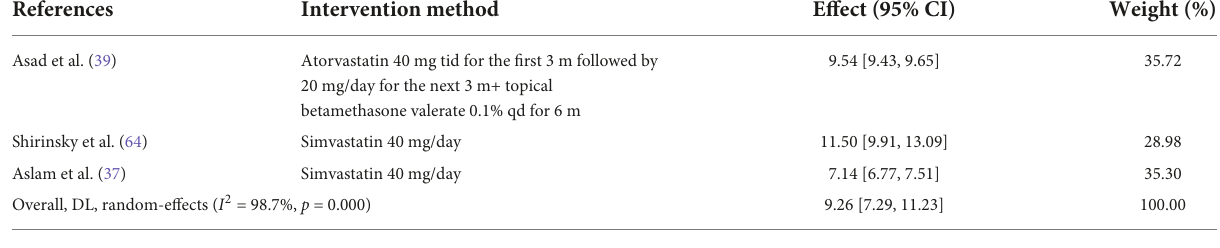
TABLE 3 Meta analysis of DLQI scores in single arm study.